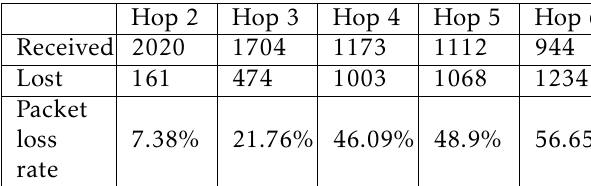
Table 4. Packet loss rate in a multiple-hop